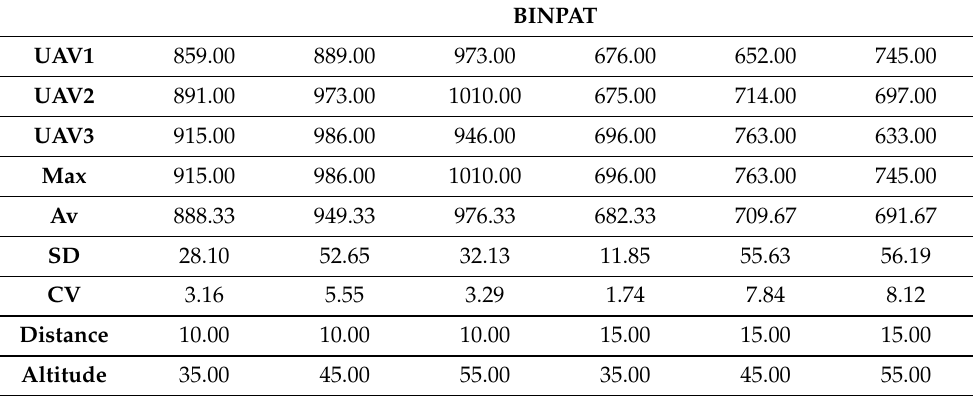
Table A8. Time results using the BINPAT algorithm and three UAVs in a long-track scenario.